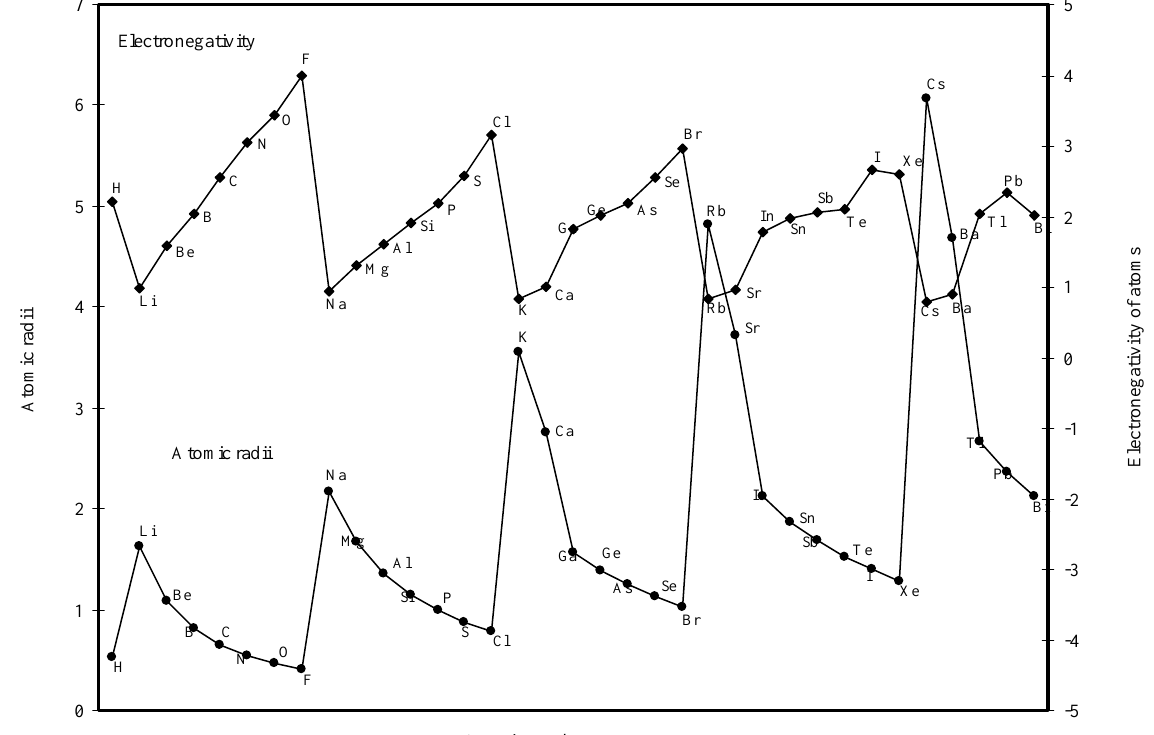
Figure 11. Plot of atomic radii and electronegativity of atoms as a function of atomic number. theoretical atomic radii are plotted as function of atomic number. Although the electronegativity is an atomic property and depends upon the atomic radii [36], it is not a directly measurable experimental quantity of an isolated atom and it has no quantum mechanical operator [6,37]. But the inverse relationship between the polarizability and hardness is well established [38]. The inverse relationship between the polarizability and the electronagativity is also suggested [6]. From an analysis of the evident mutual inter-relationship between η , α and electronegativity and their relation with atomic radii, the inverse relationship between electronegativity and atomic size is self-evident. from Fig.11 that the profile for atomic size and the profile for electronegativity are both periodic